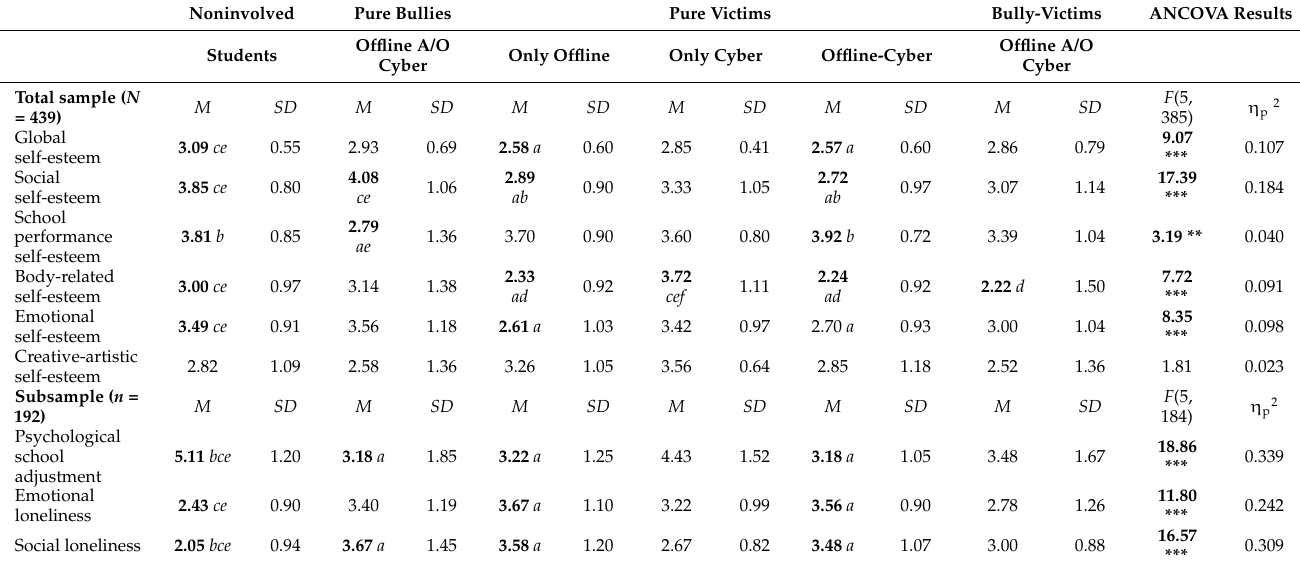
Table 4. Means and Standard Deviations in Bullying-Related Role Groups Regarding Domain-Specific Facets of Self-Esteem, Psychological School Adjustment and